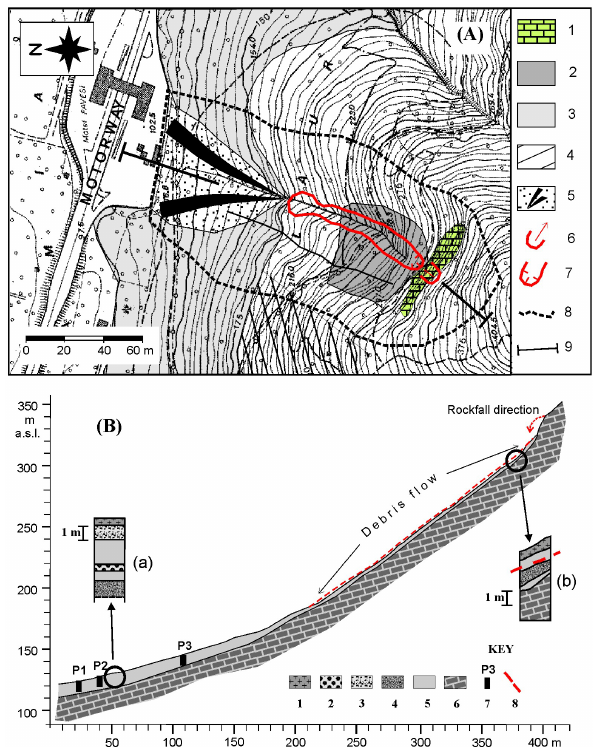
Fig. 5. (A) Geomorphological layout of the Vallone Alfaterna basin.